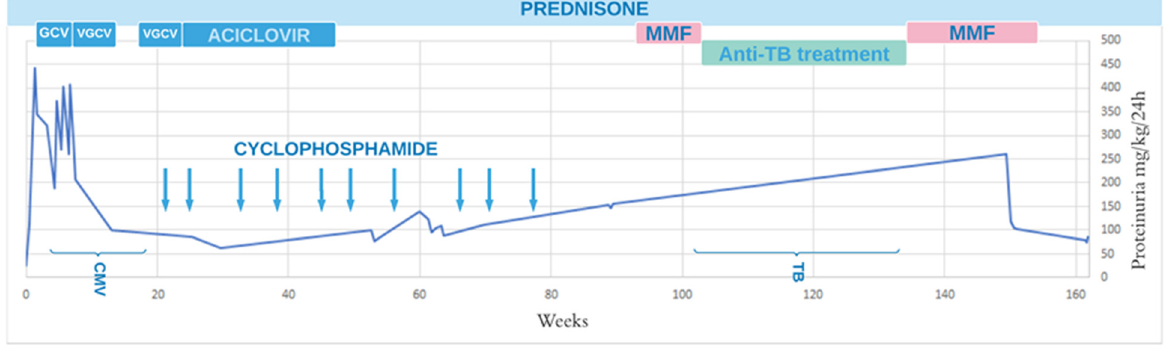
Figure 1. Treatment and proteinuria (mg/kg/day). GCV, ganciclovir; VGCV, valganciclovir; CMV, Cytomegalovirus; TB, tuberculosis.